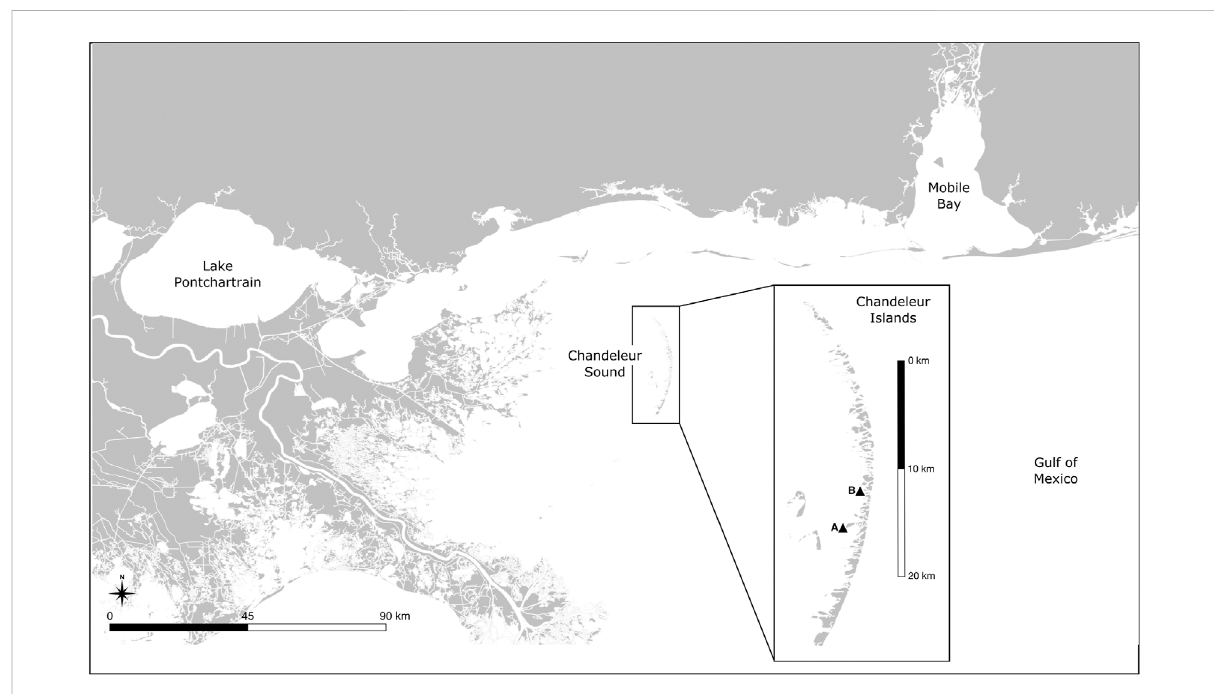
FIGURE 1 Map of the Northern Gulf of Mexico, showing the study sites in Louisiana ’ s Chandeleur Islands (inset). Site A (29 ° 51 ′ 36 ″ N 88 ° 50 ′ 24 ″ W) showed lowtonoevidenceofhydrocarboncontamination,whilesiteB(29 ° 53 ′ 24 ″ N88 ° 49 ′ 48 ″ W)showedelevatedhydrocarbonconcentrationsthroughout the upper 15 cm of sediment. The sites are 3.7 km apart and show similar physical